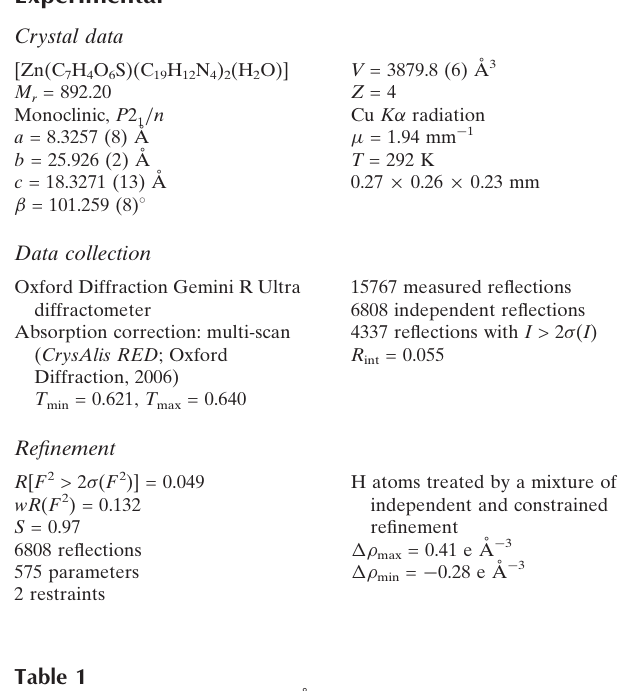
Selected geometric parameters (A˚ , (cid:3) ).